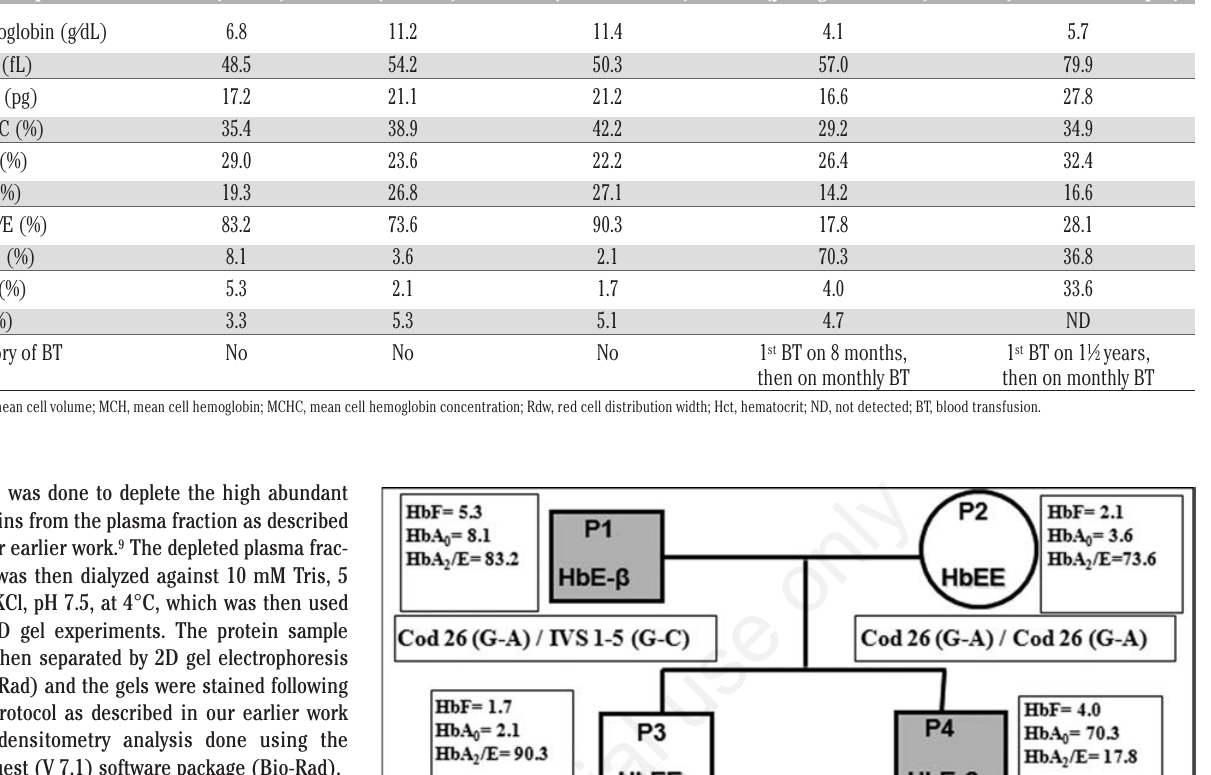
Table 1. Clinical data of the members of the family in study. Clinical parameters